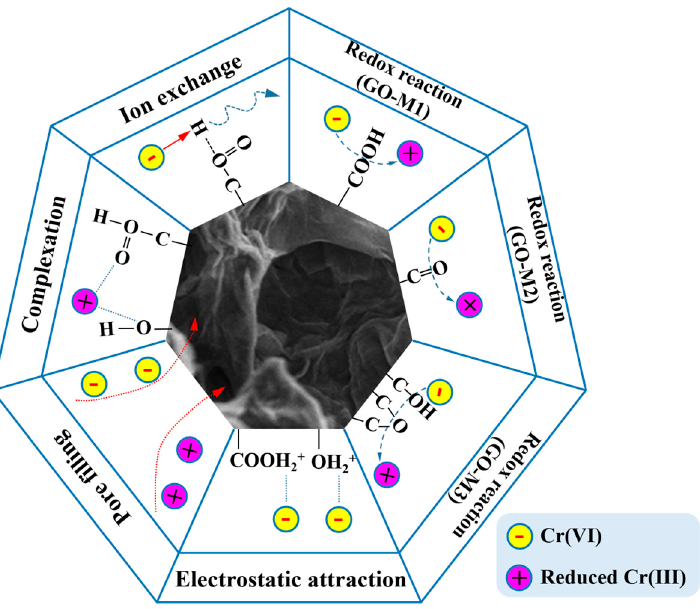
Figure 9. The underlying mechanisms of Cr(VI) adsorption on GOs (different lines represent dif- ferent forces, and arrows represent the direction of the force).